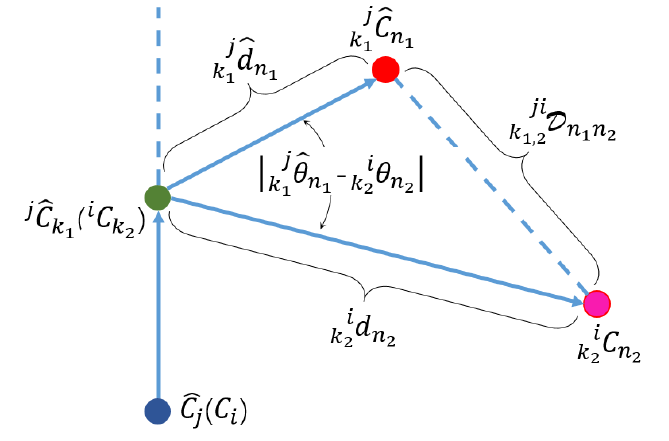
Figure 6. Geometric distance between two parameter